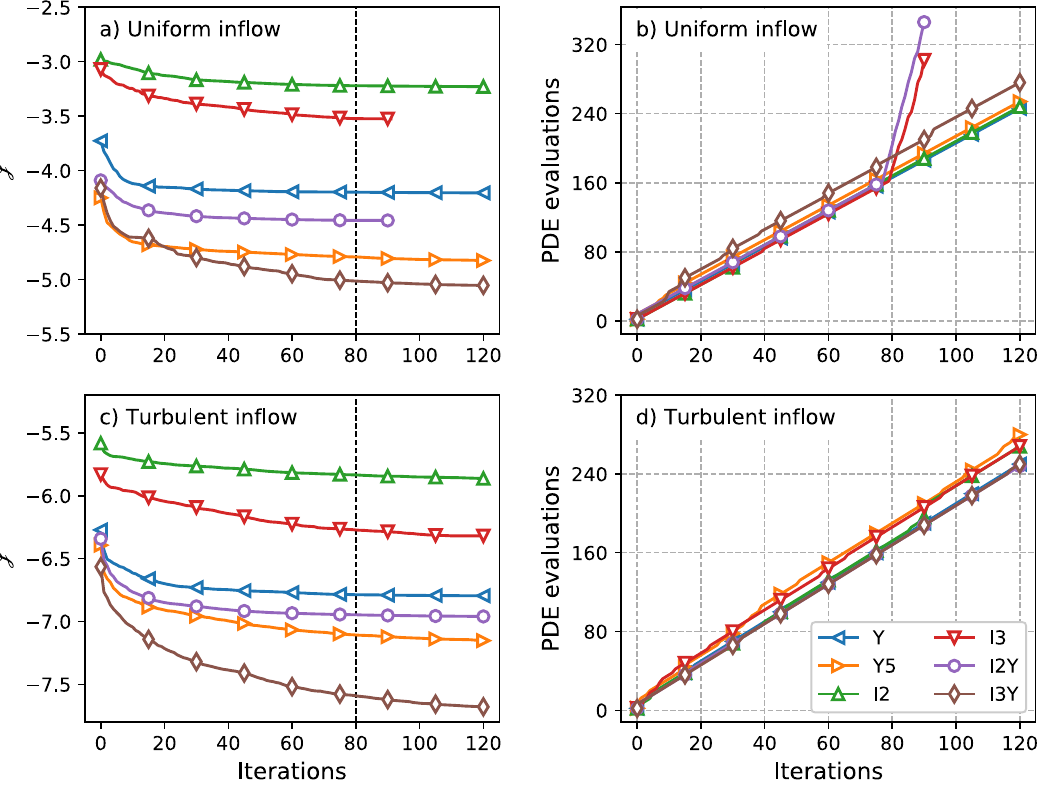
Figure 4. Convergence behavior for the second optimization window. Top ( a , b ) Uniform inflow. Bottom ( c ,d) Turbulent inflow. Left ( a , c ) Cost functional J . Right ( b , d ) PDE evaluations (forward or adjoint). Markers represent every fifteenth iteration step. The dashed vertical lines in ( a , c ) indicate 80 iterations, i.e. the amount of iterations used throughout this